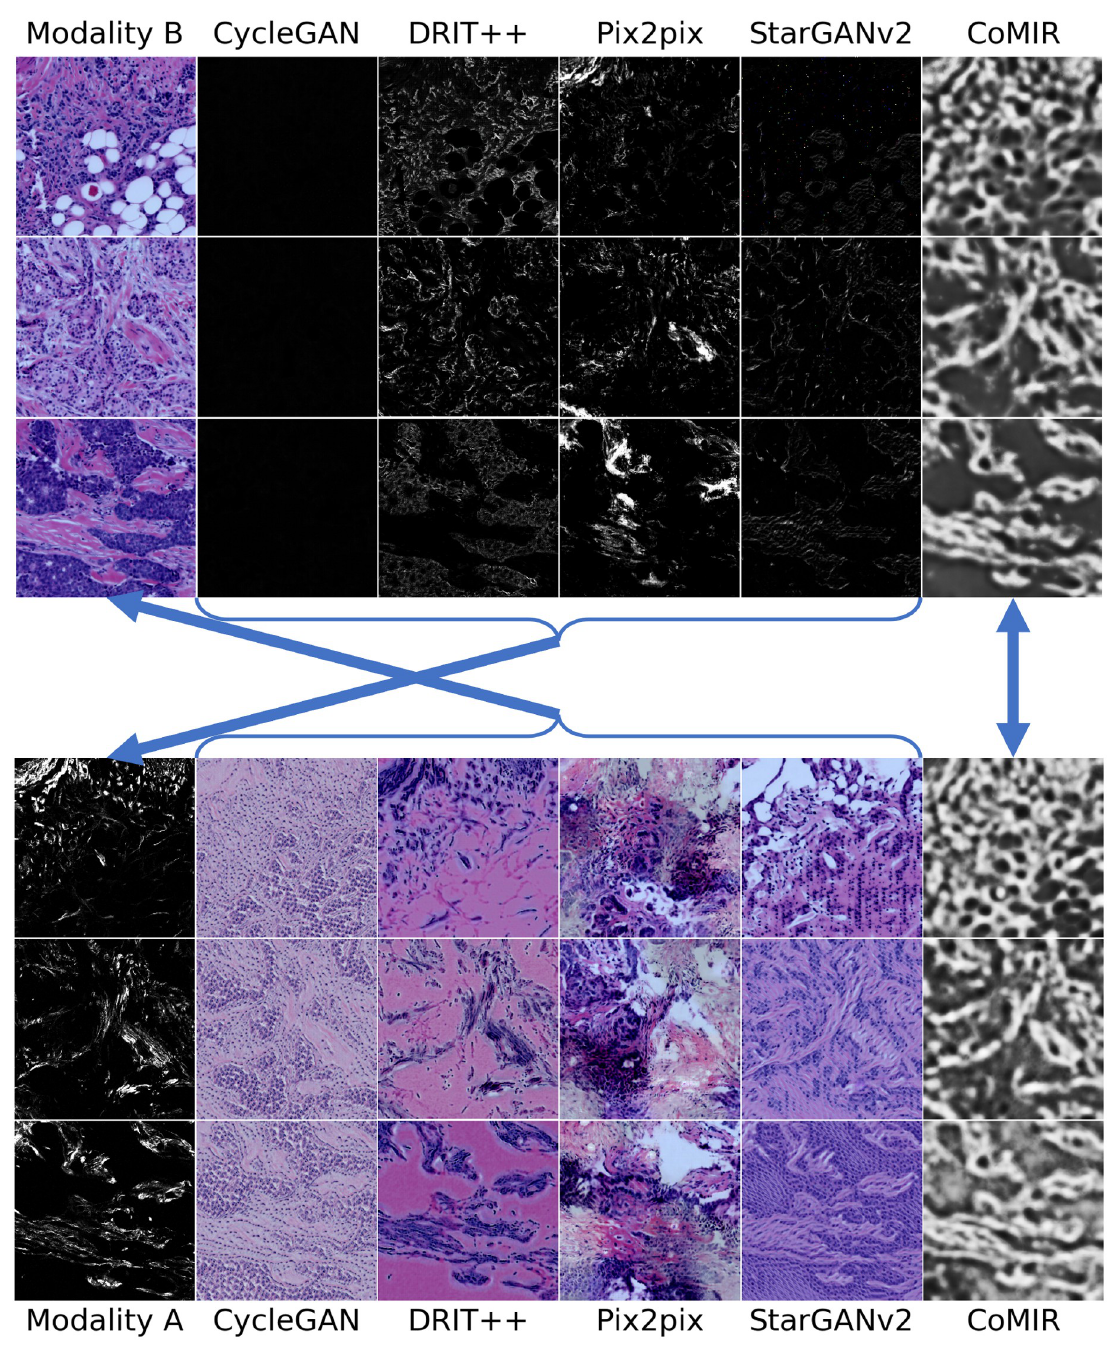
Fig 6. Modality-translated image samples of the Histological dataset by different evaluated methods (contrast-enhanced for visualisation). Each row shows the results on one random image from each fold. Images in Columns 2–6 are generated from the images in (the corresponding row of) Column 1. Top block: Translations generated from Modality B. Bottom block: Translations generated from Modality A. The arrows indicate what to compare for visual inspection of the level of achieved similarity (pointing from generated images to the corresponding target of the learning